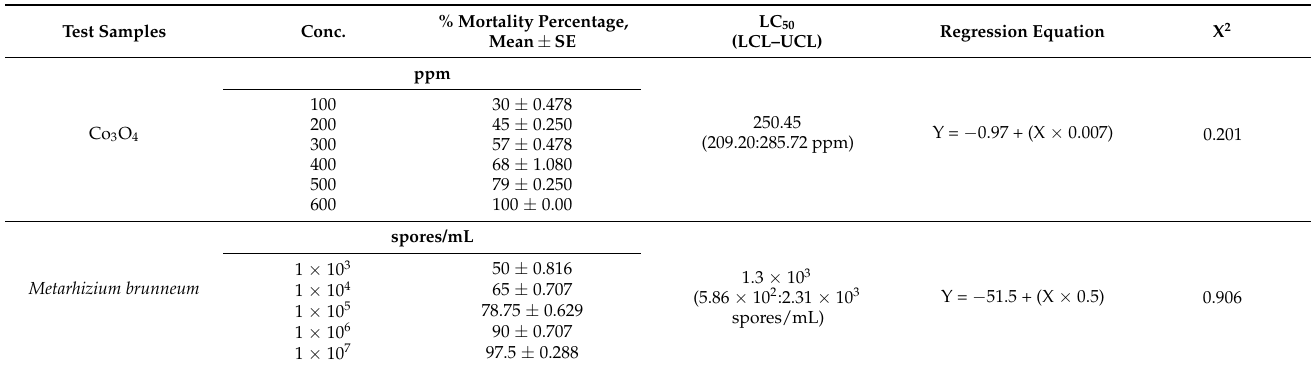
Table 2. Toxic effect of fungus, M. brunneum , and Co 3 O 4 NPs against 3rd larval instar of C. pipiens .